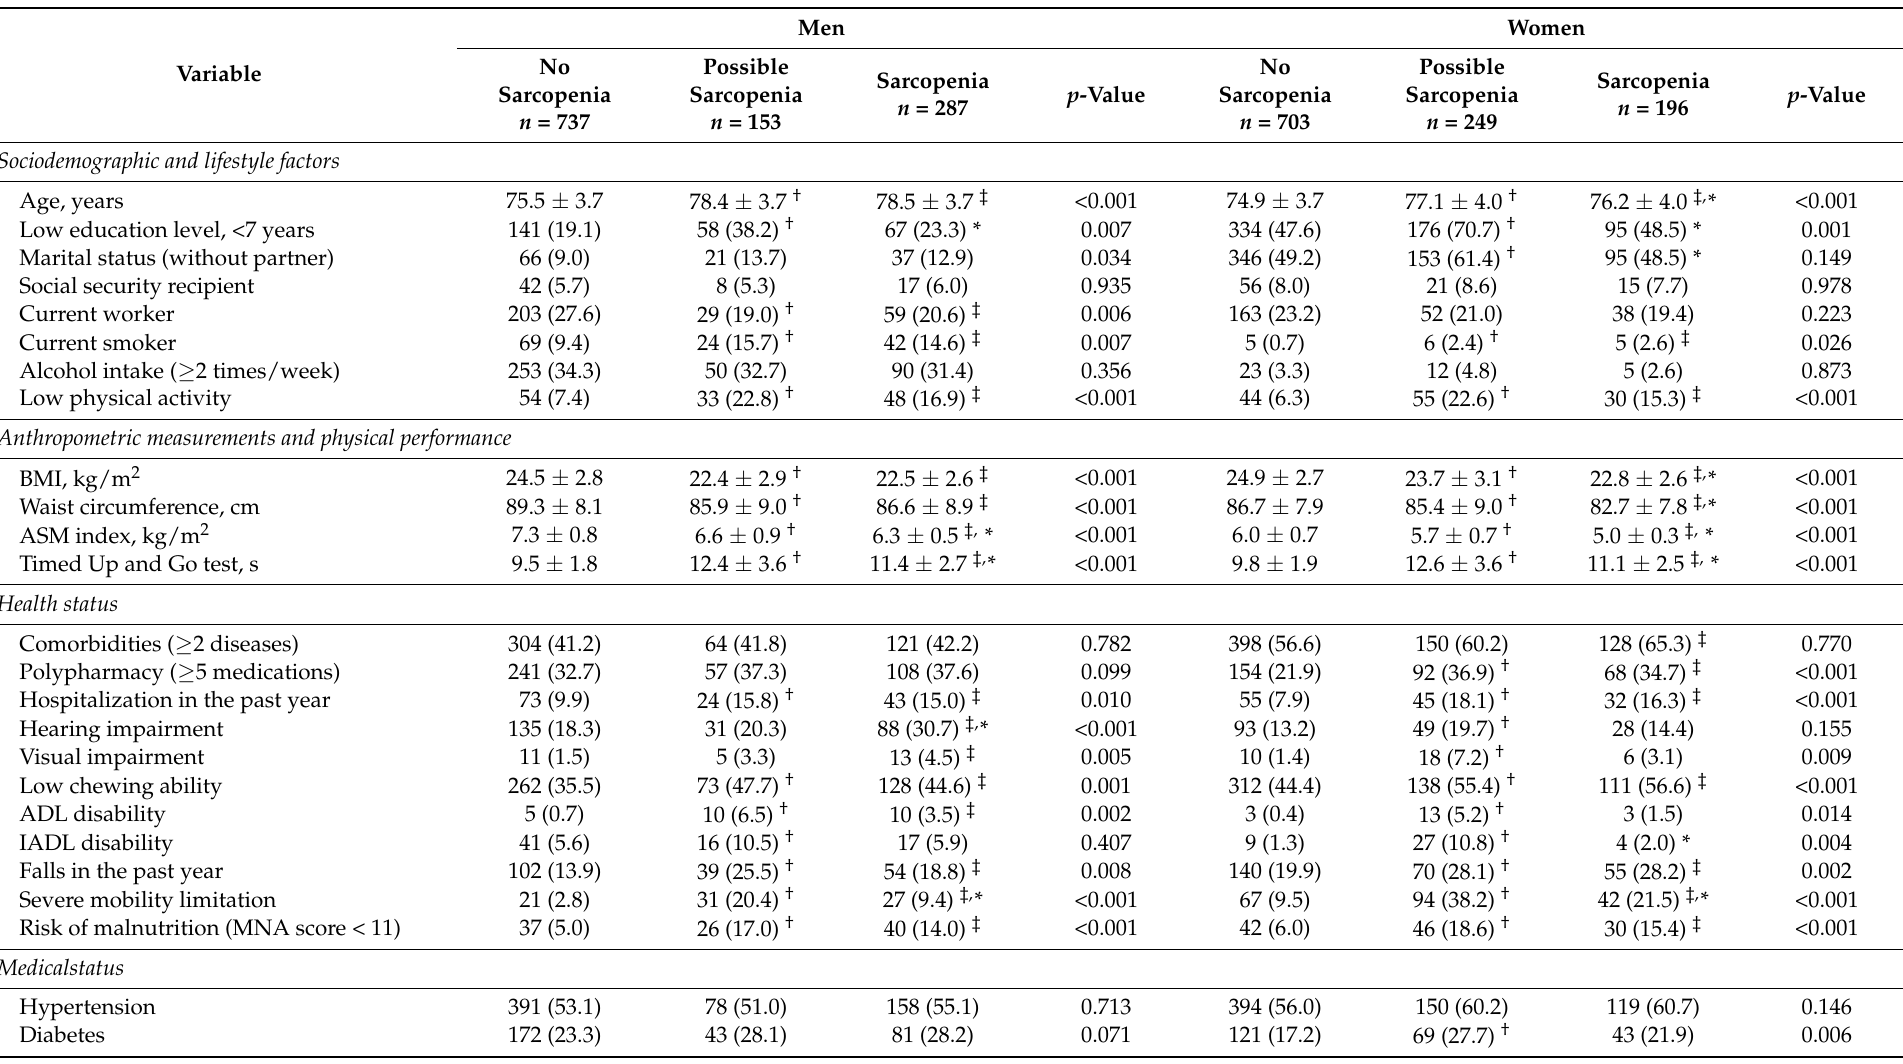
Table 1. Characteristics of the study participants in the no sarcopenia, possible sarcopenia, and sarcopenia